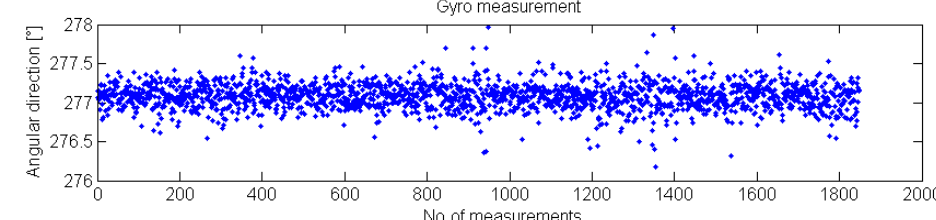
Figure 3. Long-term series of interpolated four-position gyro-north-seeker measurement (trace on horizontal circle).